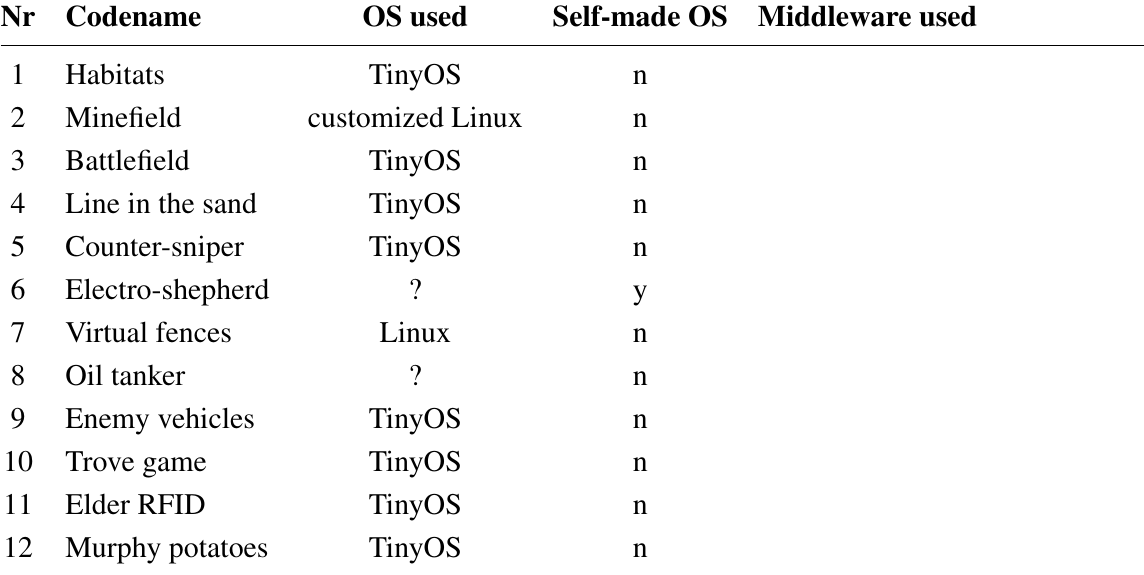
Table 13. Deployments: used operating system (OS) and